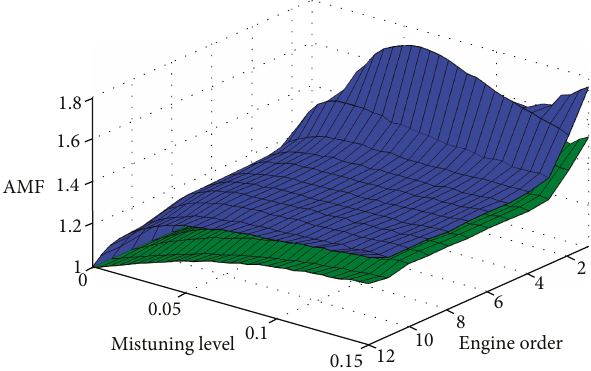
Figure 13: Response localization factor of the mistuned blisk with (red) and without (blue) SSDNC.